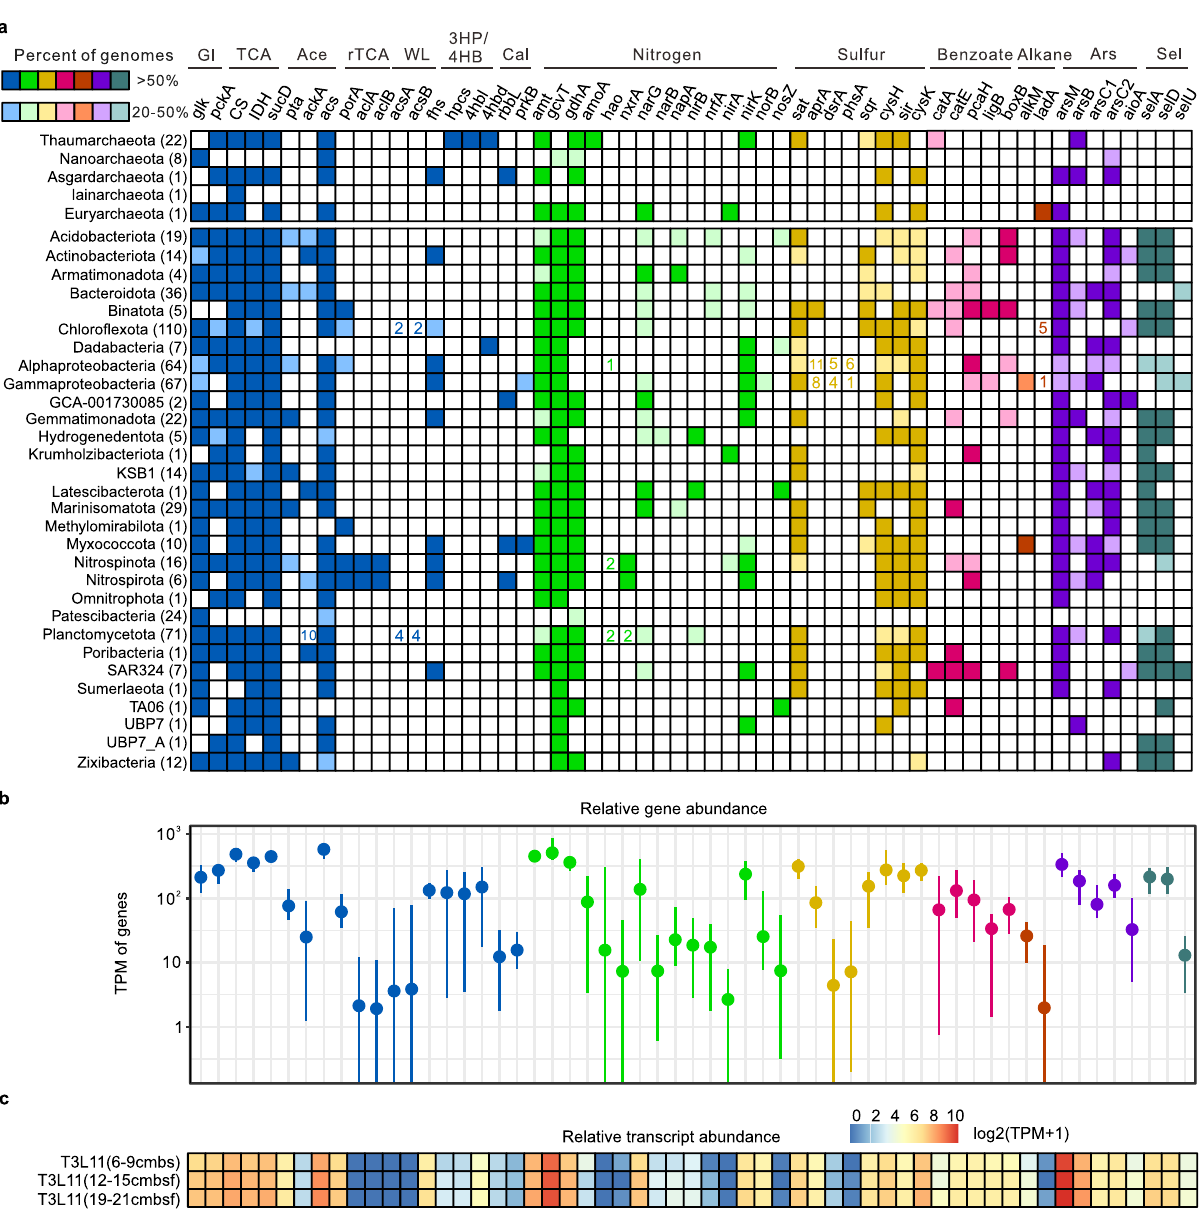
Fig. 3 Presence of selected metabolic genes in the 37 metagenomes and the three bottom-axis sediment metatranscriptomes. a Heatmap of various metabolic genes across phyla (class level for Proteobacteria) found in the CD sediments. Light colors indicate genes present at 20 – 50% in the retrieved MAGs. Darker colors indicate genes present at 50 – 100% in the retrieved MAGs. The number of genomes per phylum is shown in the parentheses. The number of key genes present in <20% of genomes is given in the squares. b Mean relative gene abundances across the 37 metagenomes. The bars indicate the minima and maxima of the gene abundances. c Heatmap of the relative abundance of transcripts (TPM) in the three metatranscriptomes (6 – 9, 12 – 15, 15 – 21 cmbsf) from the bottom-axis sediment sample at the T3L11 site (10,908m). Gl glycolysis and gluconeogenesis, TCA tricarboxylic acid cycle, rTCA reductive tricarboxylic acid cycle, Ace acetate metabolism, WL Wood – Ljungdahl pathway, 3HP/4HB 3-hydroxypropionate/4-hydroxybutyrate cycle, Cal Calvin cycle, Asr arsenate metabolism, Sel selenate metabolism, TPM transcripts per million. Details of the metabolic genes can be found in Supplementary Data 7. Source data are provided as a Source data fi